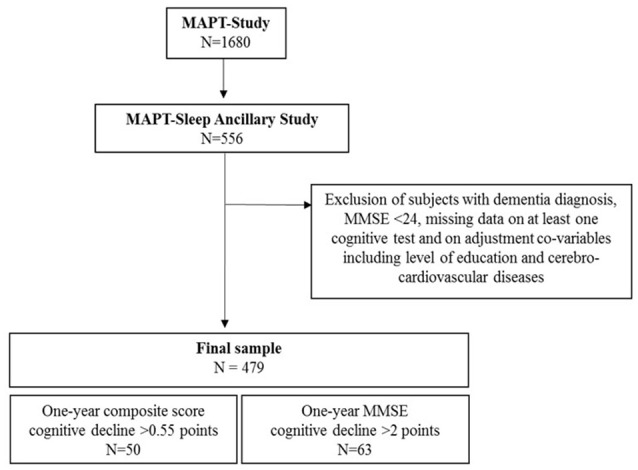
Study flow chart.